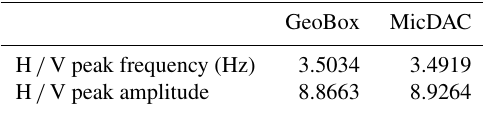
Table 2. H / V peak frequencies and amplitudes calculated from the data recorded simultaneously by GeoBox and